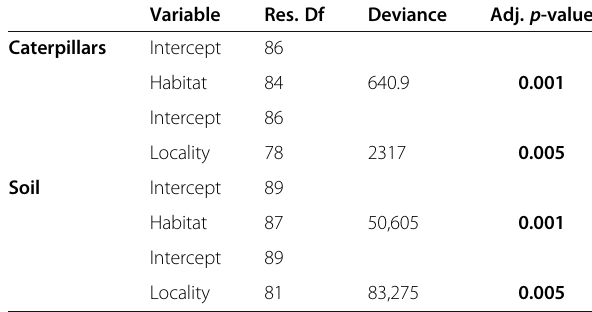
Table 1 Microbial composition of caterpillars and soil